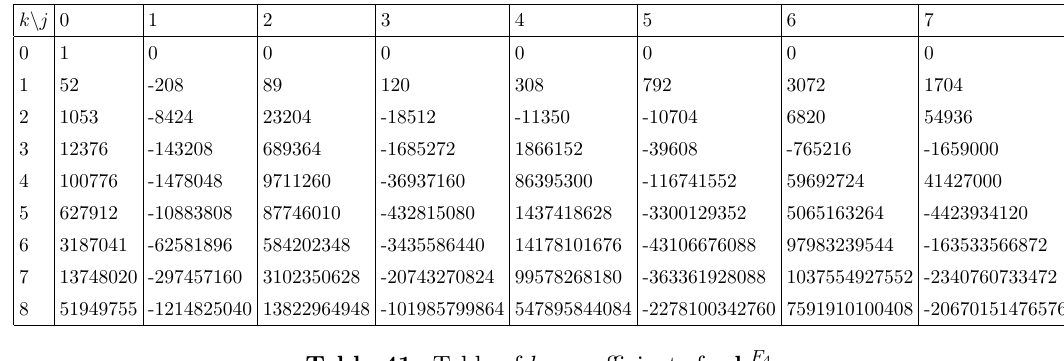
Table 41. Table of b jk coe(cid:14)cients for h F 4